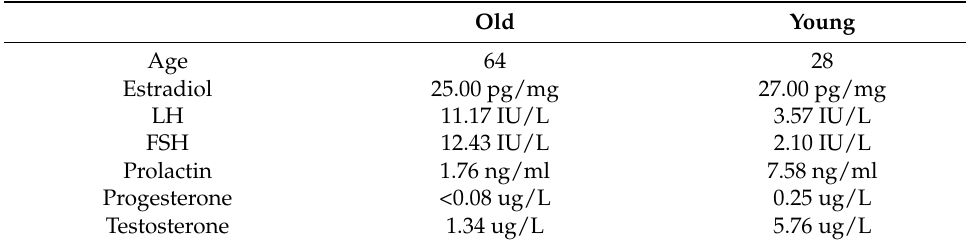
Table 1. Donor age and hormone